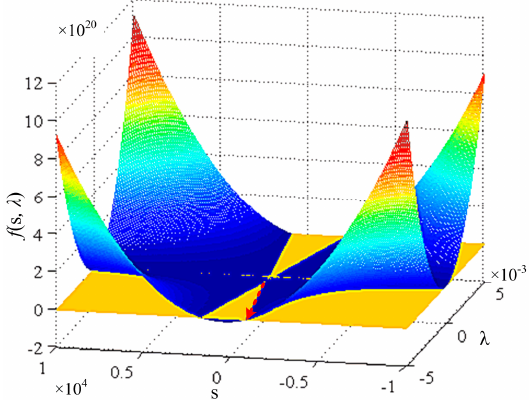
Figure 5. The three-dimensional plot of f ( s , λ ).